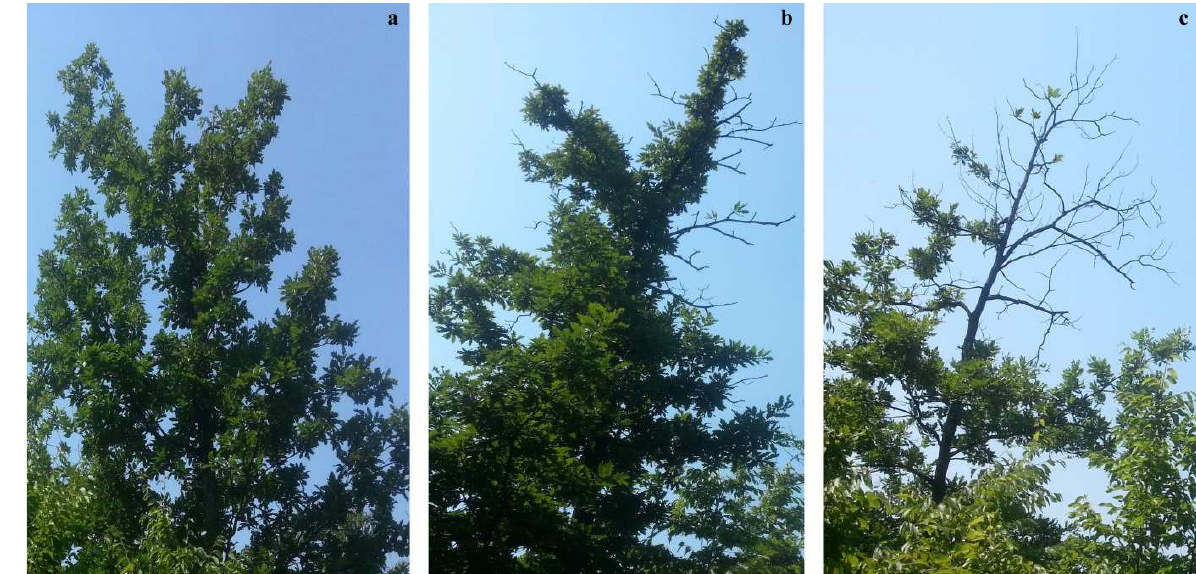
Figure 6. An illustration of defoliation assessment: ( a ) 10%; ( b ) 25%; ( c ) 65%.